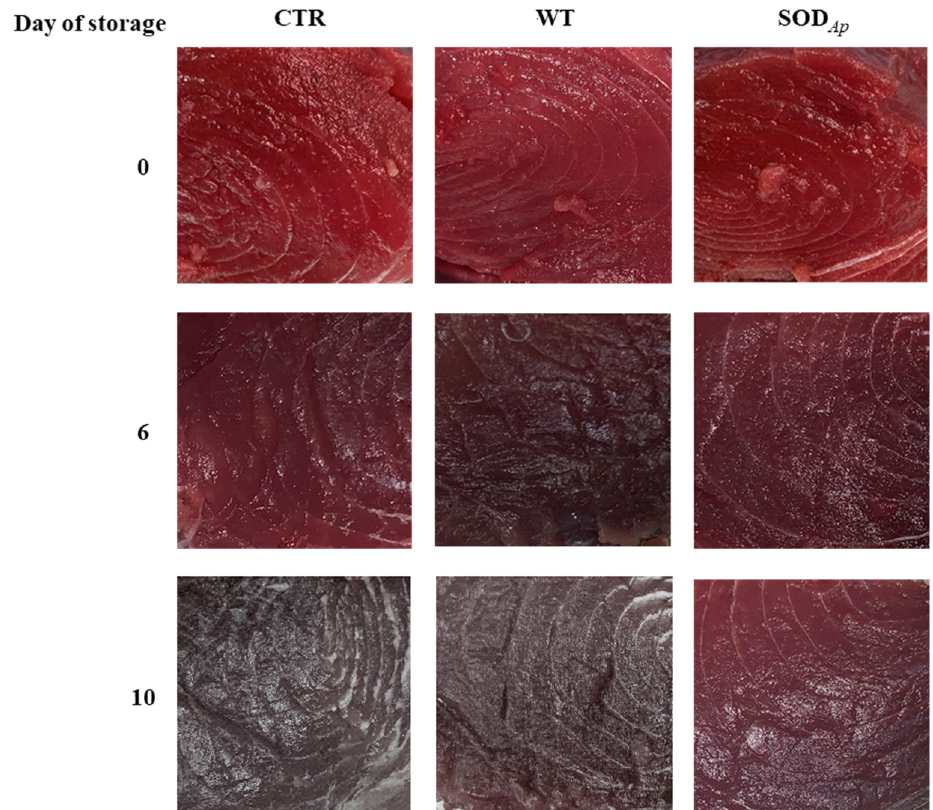
Figure 7. Appearance of Thunnus thynnus slices stored for 10 days at refrigerated temperature (4 ± 1 °C). The samples were injected with aqueous solutions containing water only (CTR), extracts from tomato cell lines non-transformed with sod Ap (WT), extracts from tomato cell lines transformed with sod Ap (SOD Ap ).